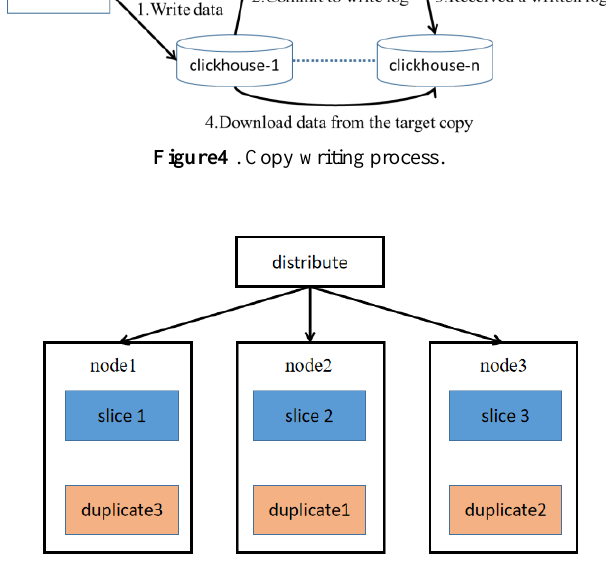
Figure5 . Design architecture of sharded